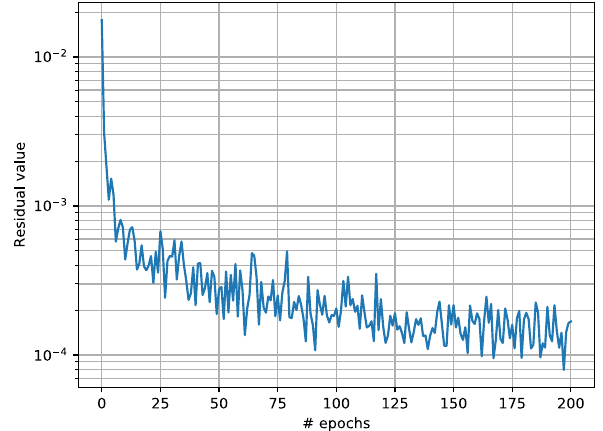
Figure 2. Residual values for each epoch for M = 4.5 values in a semilog